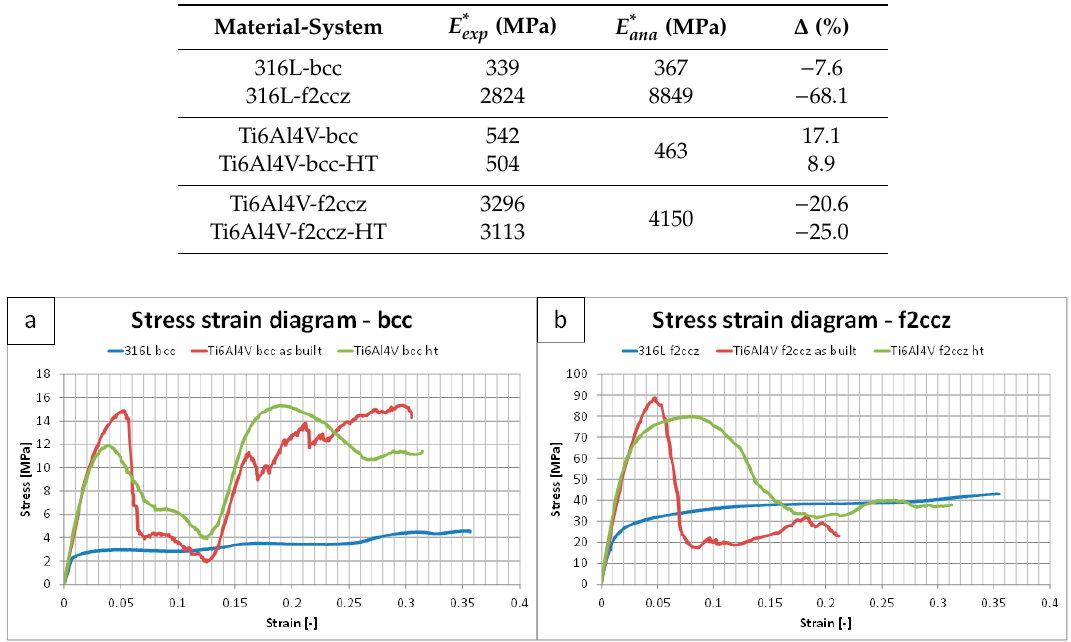
Figure 9. Experimental results–representative stress–strain diagram for all types of lattice structures obtained by compression testing, partly recompiled from [35–39,46].